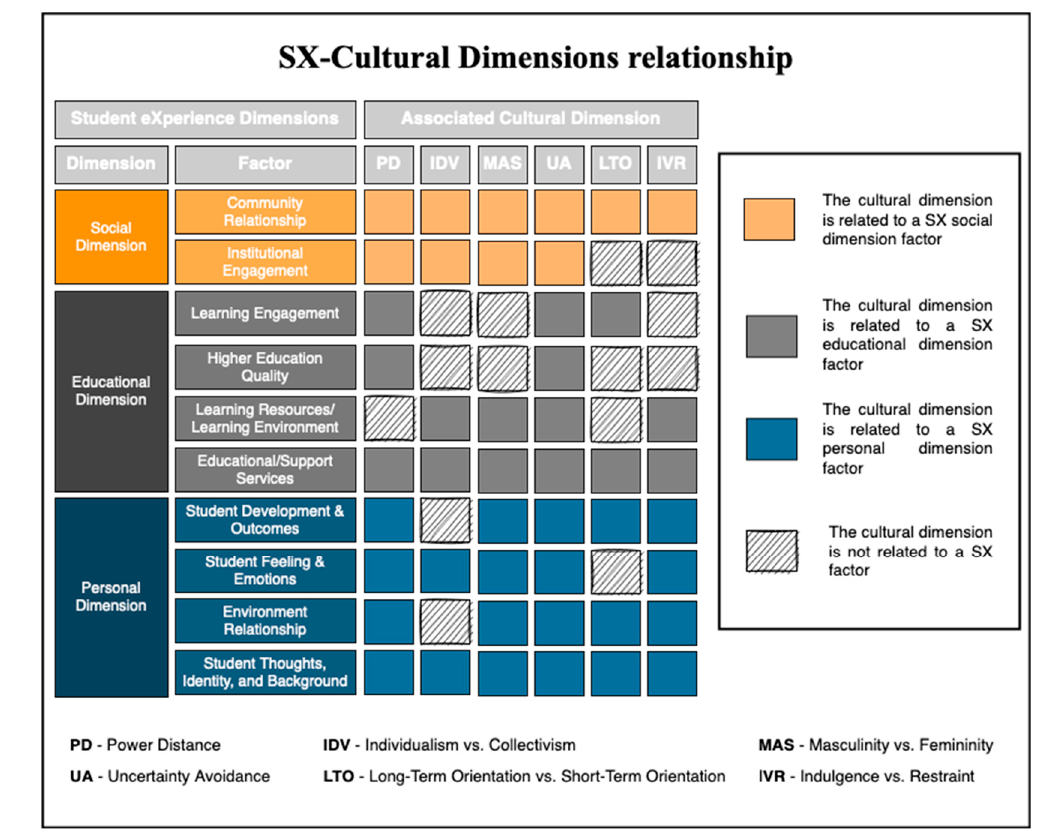
Figure 3. SX cultural dimensions relationship.